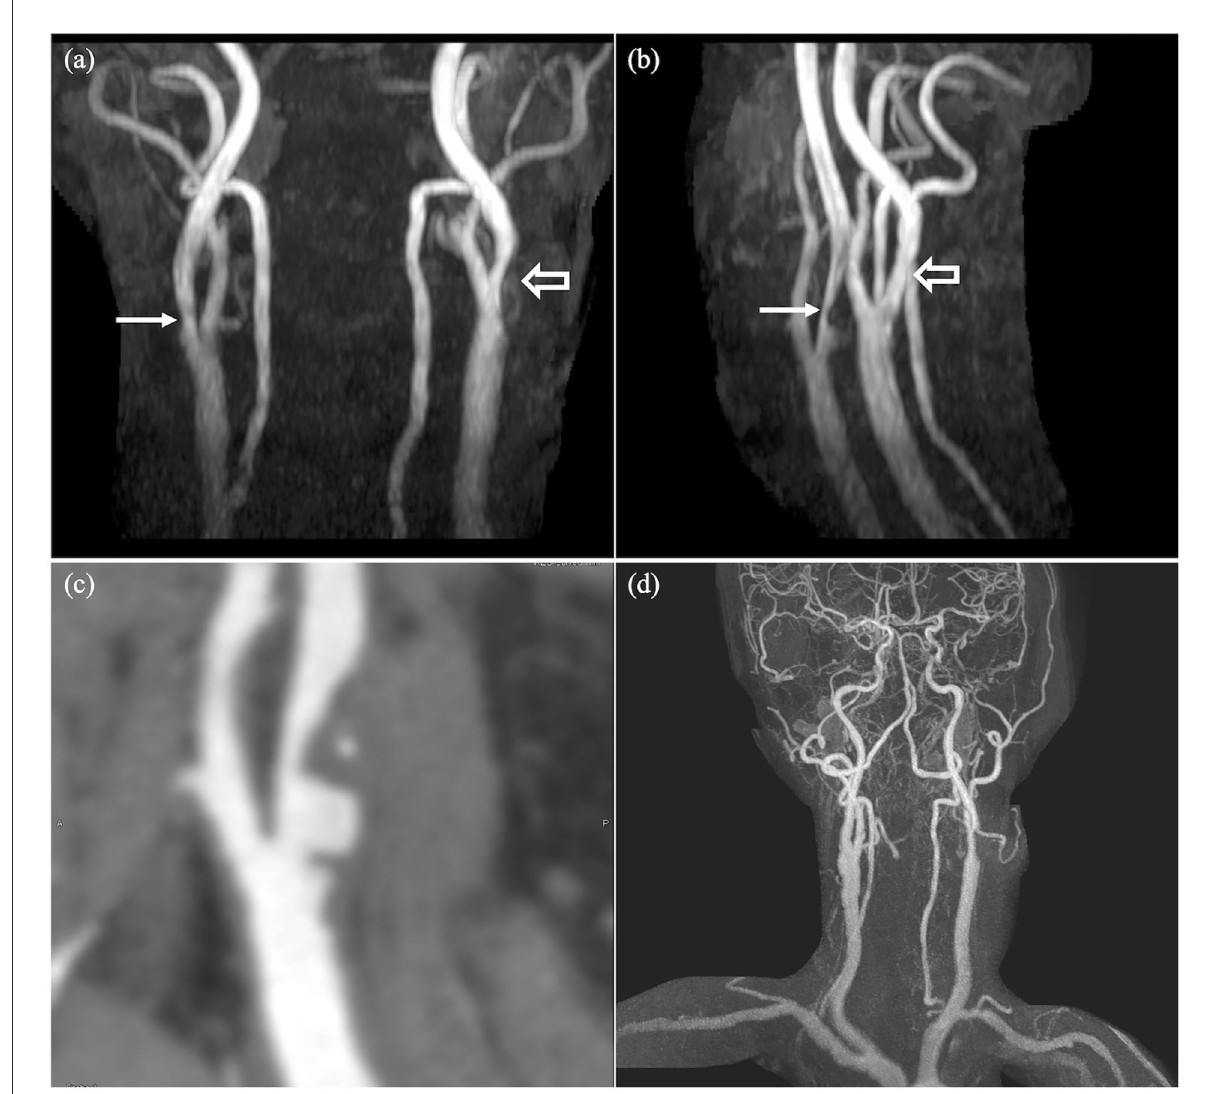
FIGURE3 An incidentally detected significant extracranial stenosis in a 71 year-old-male with cognitive impairment. A severe stenosis at right proximal ICA (arrows) and a mild stenosis at left proximal ICA (open arrows) are noted on TOF-MRA (a,b) . CT angiography demonstrates non-calcified plaque at right proximal ICA resulting in severe stenosis (c) . Contrast-enhanced MR angiography after carotid endarterectomy shows successful dilatation of the right ICA (d)